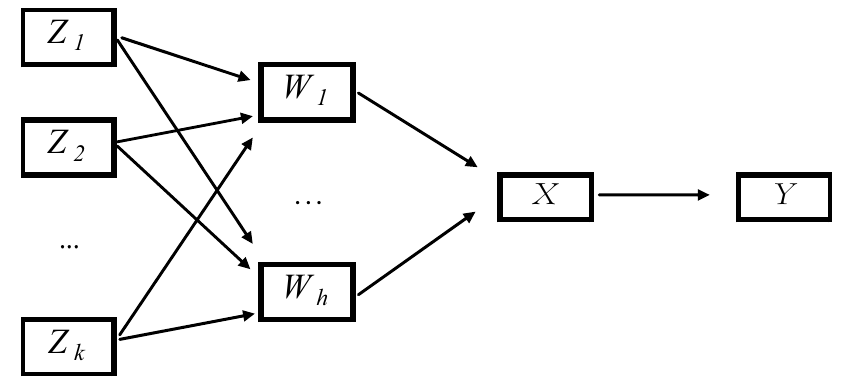
Figure 1 – Latent class model of financial